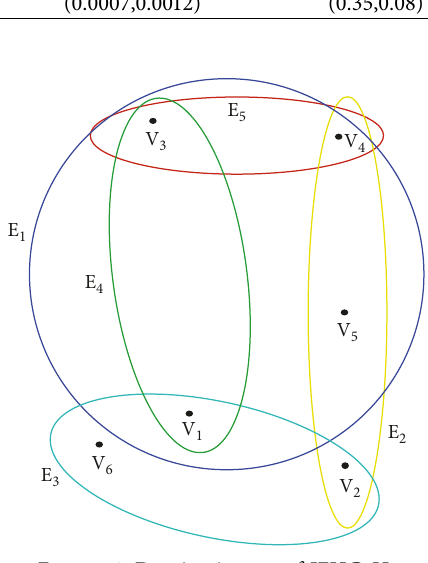
Figure 4: Dominating set of IFHG H . Table 4: Degree of membership and nonmembership values for vertices and edges of Figure